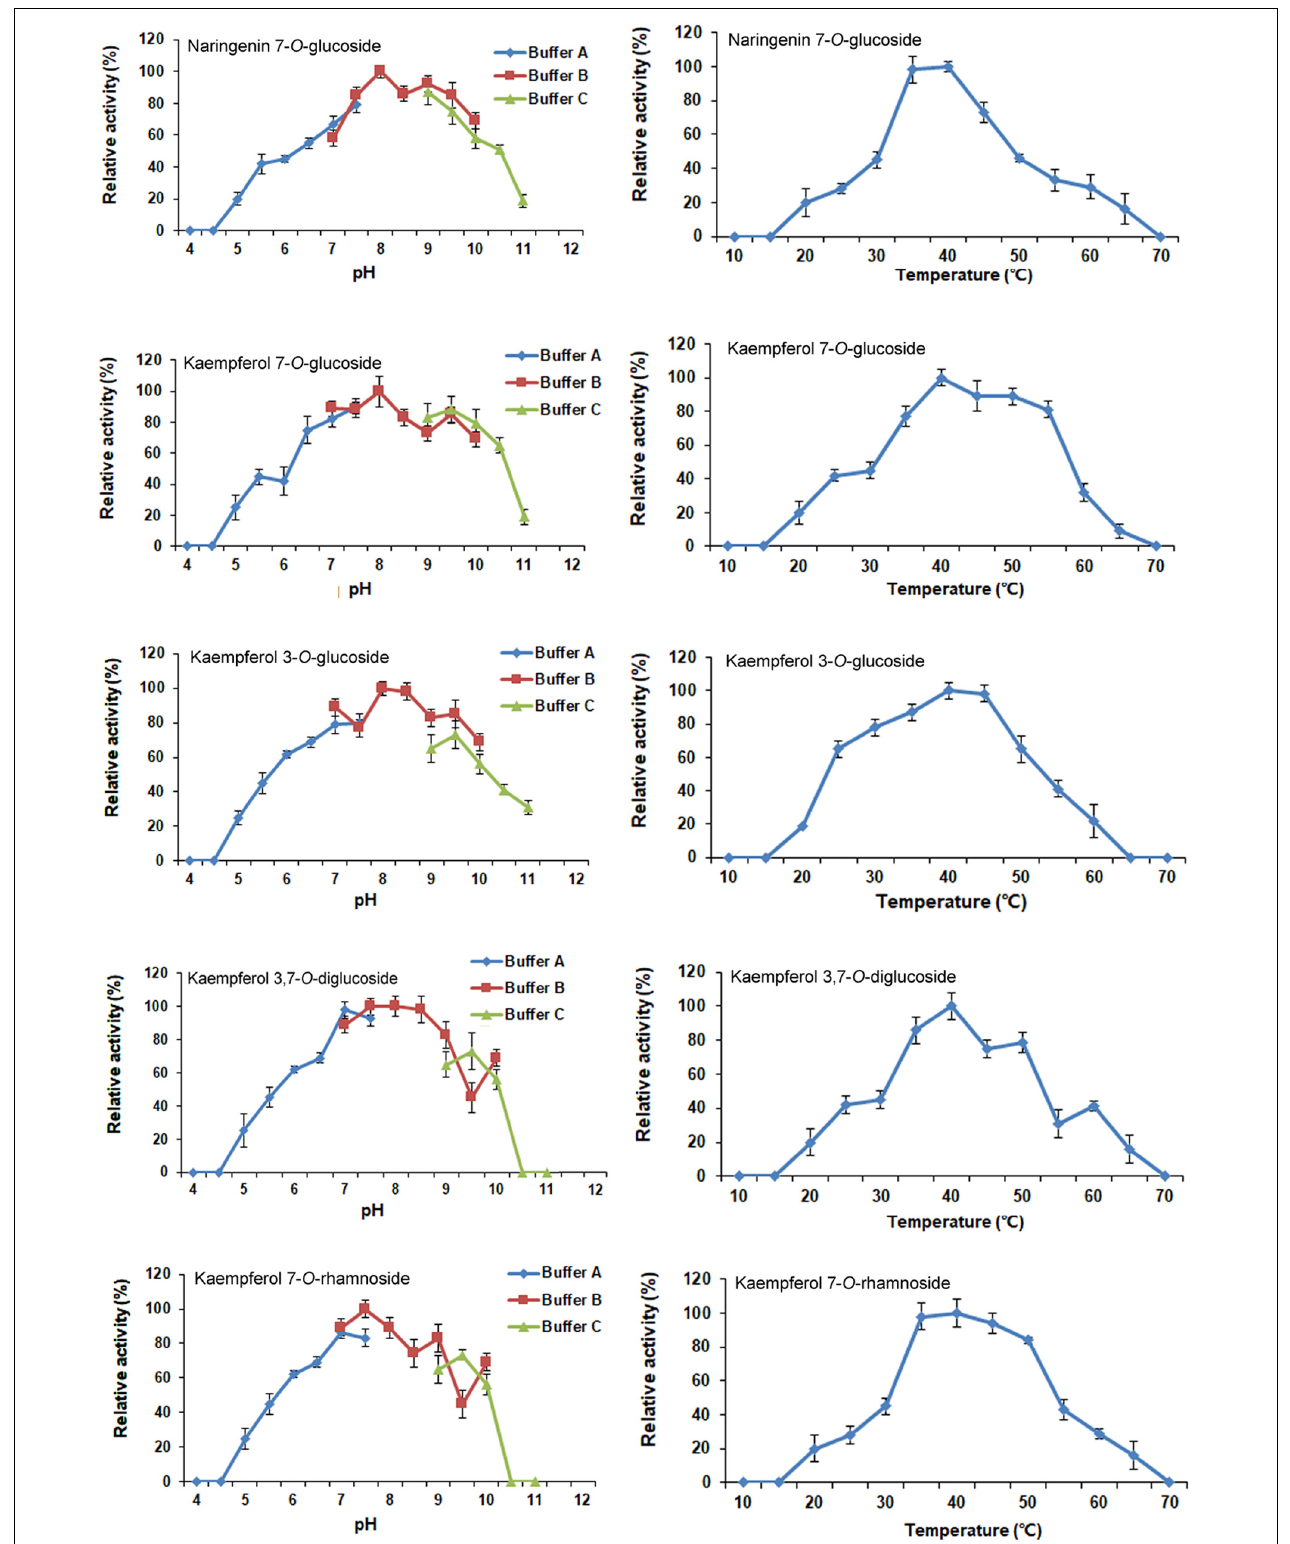
FIGURE 6 | Optimization of reaction pH and temperature of recombinant CsUGT76F1. Buffer A: acid-sodium citrate buffer (pH 4.0–7.5). Buffer B: Tris-HCl buffer (pH 7.0–10.0). Buffer C: NaHCO 3 –Na 2 CO 3 buffer (pH 9.0–11.0).